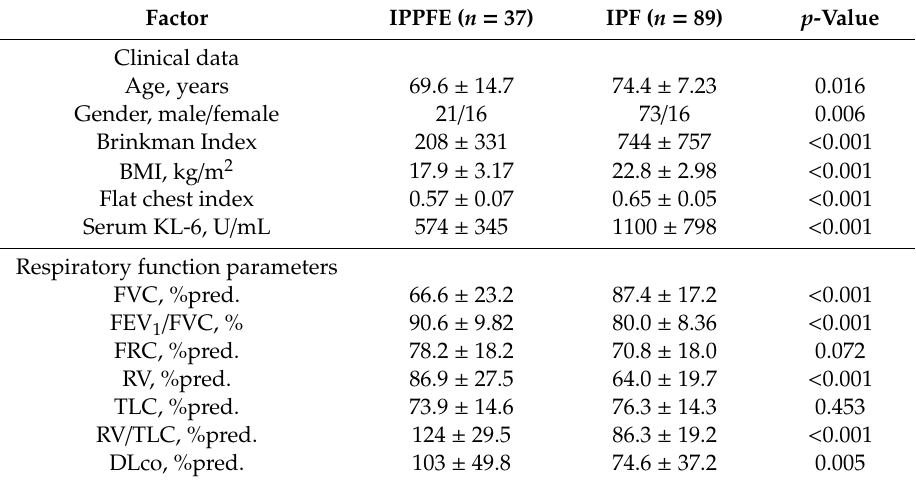
Table 1. Clinical characteristics.